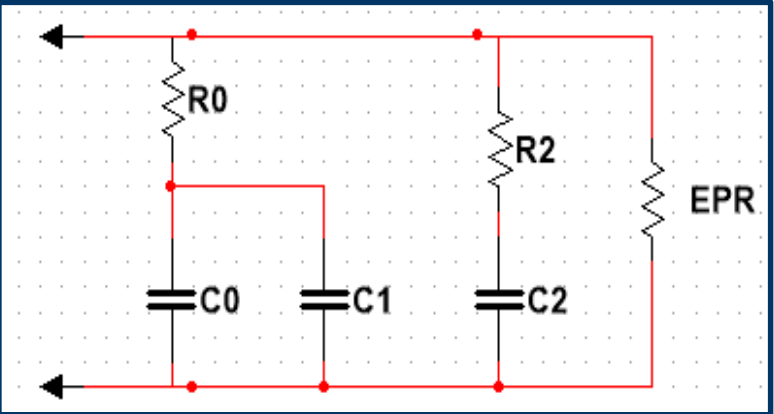
Figure 2. Two-branch model or Faranda model